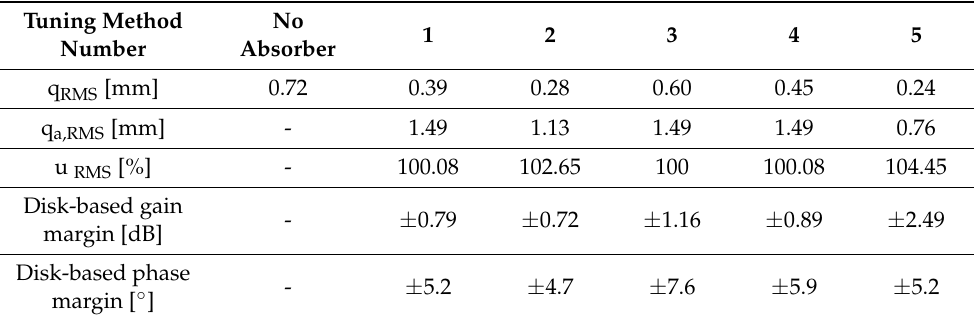
Table 2. Summary of the harmonic response of the primary system controlled through different ATMDs and robustness of the closed-loop